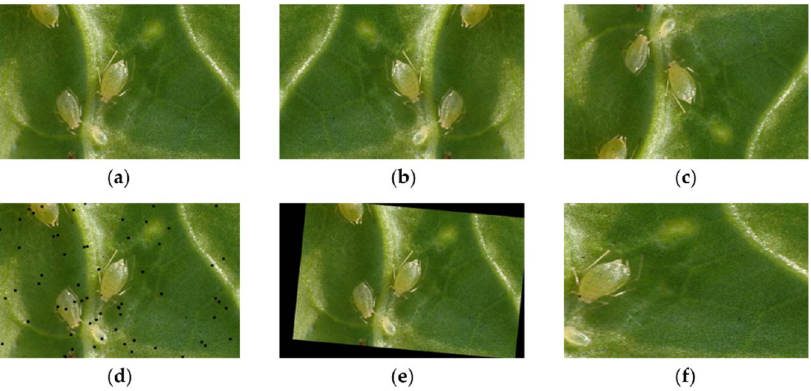
Figure 1. All data augmentation methods used in the study: ( a ) original image; ( b ) HorizontalFlip; ( c ) VerticalFlip; ( d ) cutout; ( e ) ShiftScaleRotate; and ( f ) RandomResizedCrop. Table 1. The details of the CP15 dataset.